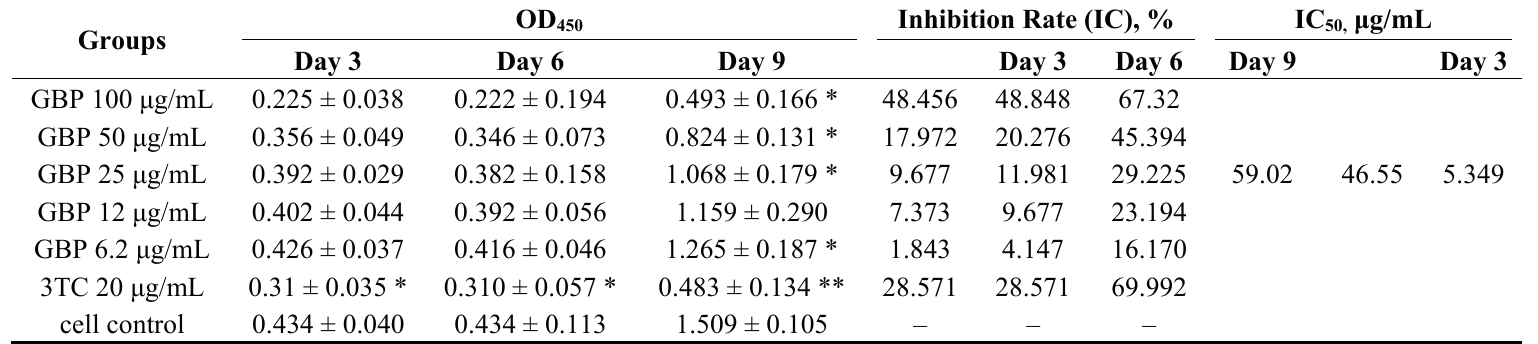
Table 4. Inhibitory effect of GBP on HBsAg secreted by HepG 2215 cells ( χ ± s, n = 4).